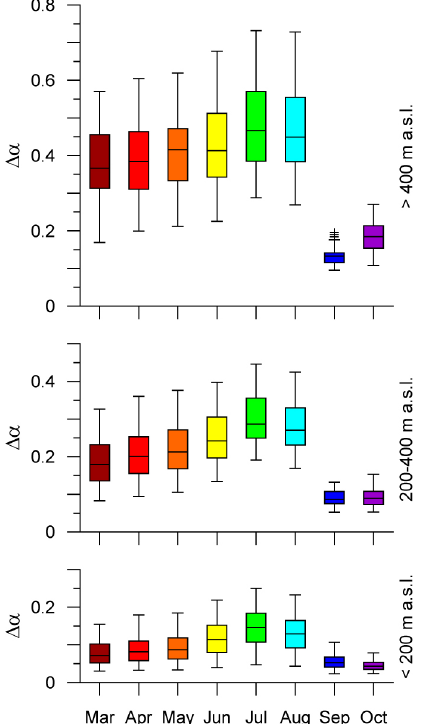
Fig. 8. Overall sensitivity of modelled albedo values towards mu- tual variations of all parameter functions of the FAM according to Eq. (12). Given albedo deviations ( 1α ) reflect the model sensitiv- ity within the ± one standard deviation uncertainty ranges of the parameter functions (Fig. 3). Box plots are created from data of a specific subset of terrain elevations given at the right of each graph. They are designed as in Fig. 4, the colour code corresponds to Fig. 7. Data are based on the period March–October of the years 2001– 2008.